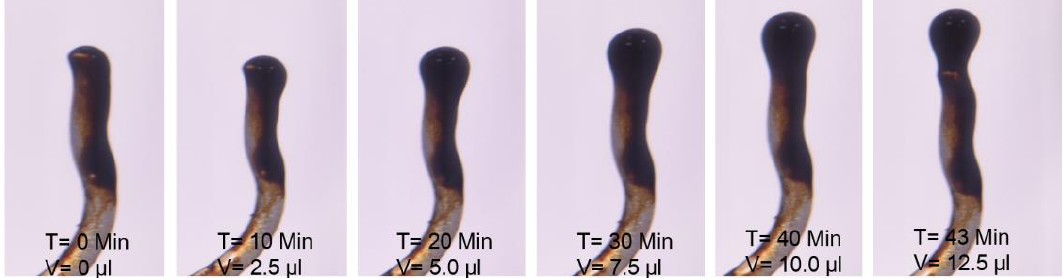
Table 8. Oil-drop size analysis before snap-off.